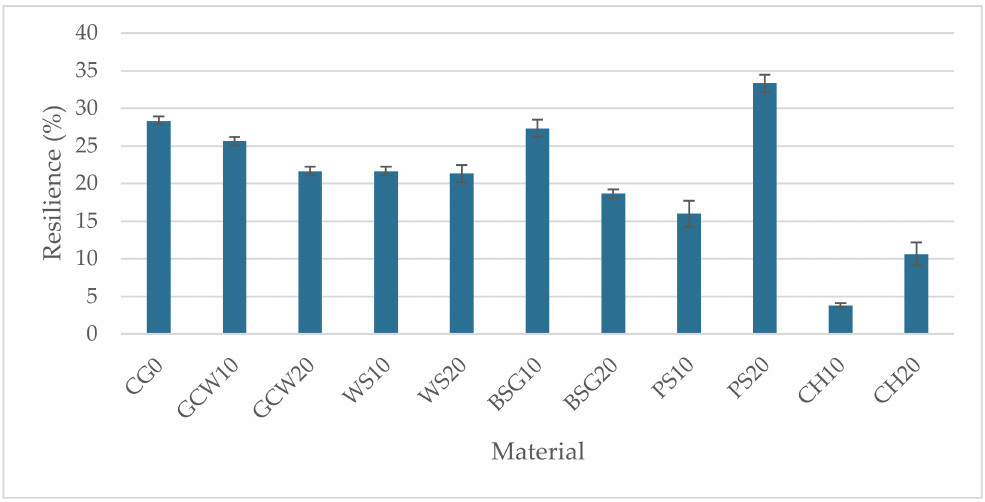
Figure 8. Materials’ rebound resilience